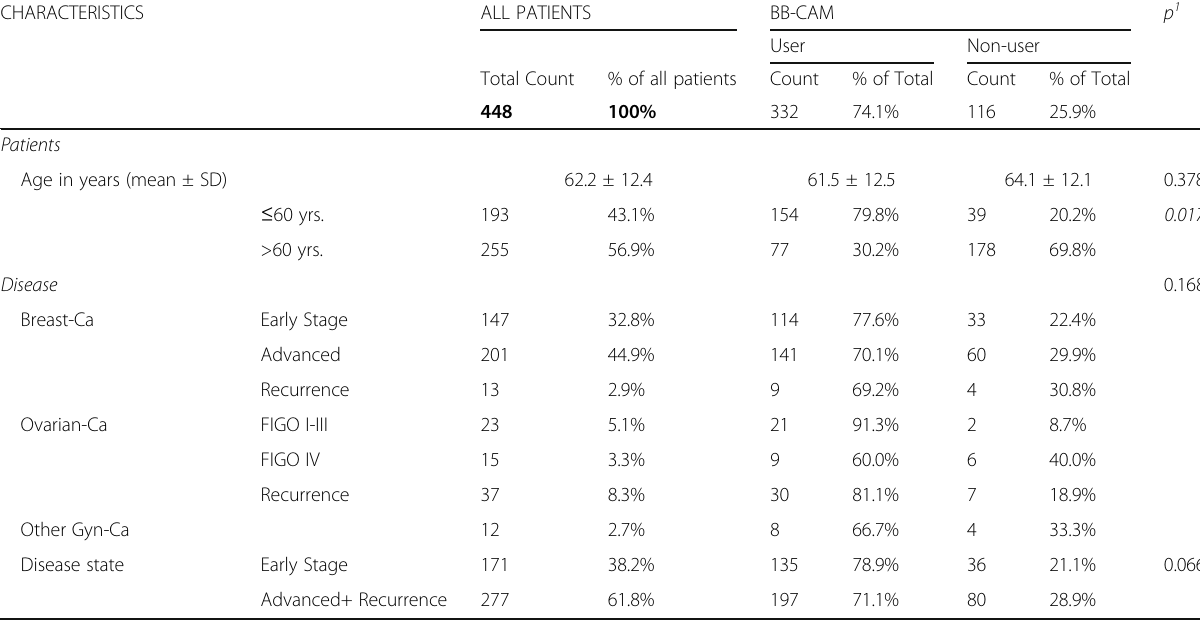
Table 1 Selected patients- and disease characteristics of the total study cohort with univariable analyses of BB-CAM use